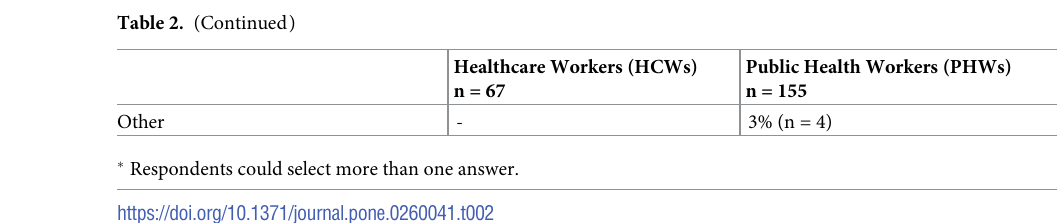
PLOS ONE | https://doi.org/10.1371/journal.pone.0260041 November24,